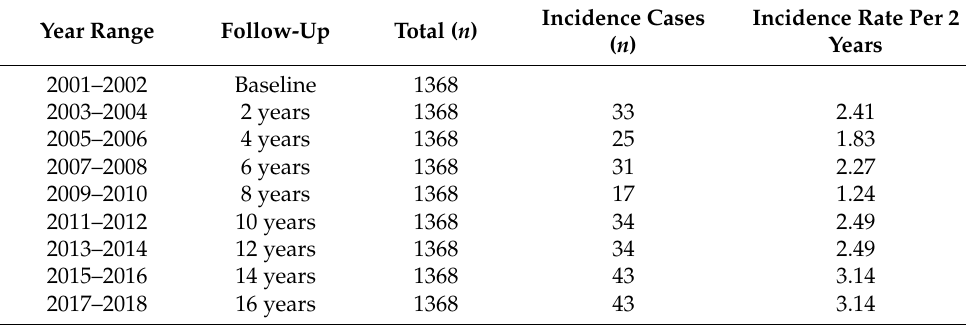
Table 2. Incidence of ALF during follow-up of participants with